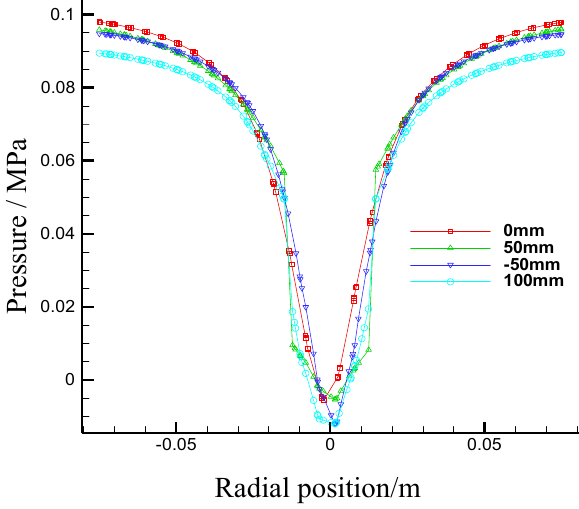
Figure 14. Pressure distribution inside cyclone with different insertion depth of inner vortex finder.